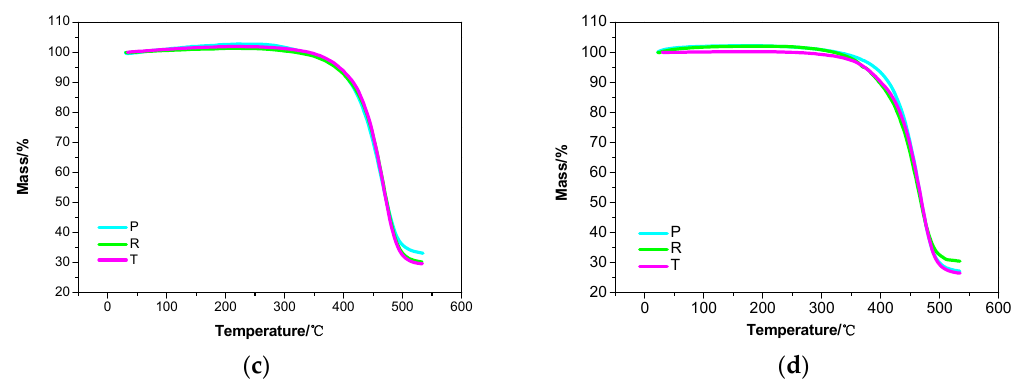
Figure 7. TG analyzer results of three kinds of asphalts (P, R, and T) under different environmental combinations: ( a ) under combination A; ( b ) under combination B; ( c ) under combination D; and ( d ) under combination F.